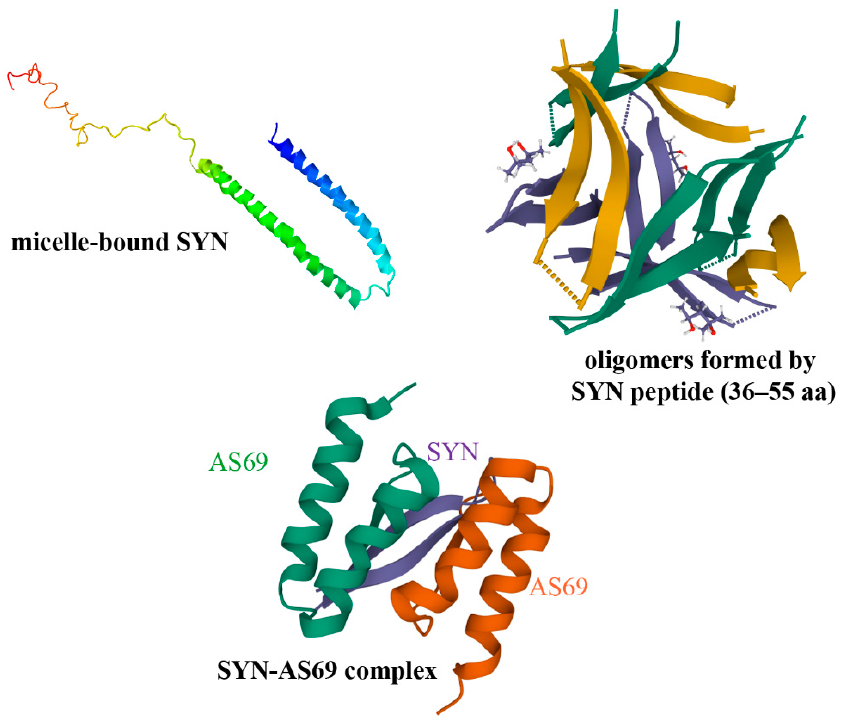
Figure 2. SYN structures: monomeric SYN (Protein Data Bank PDB 1XQ8 [46]), oligomeric SYN (PDB 5F1W [47]) and SYN (purple) complexed with small molecule (AS69 peptide, green and orange) (PDB 4BXL [48]), which inhibits SYN aggregation.